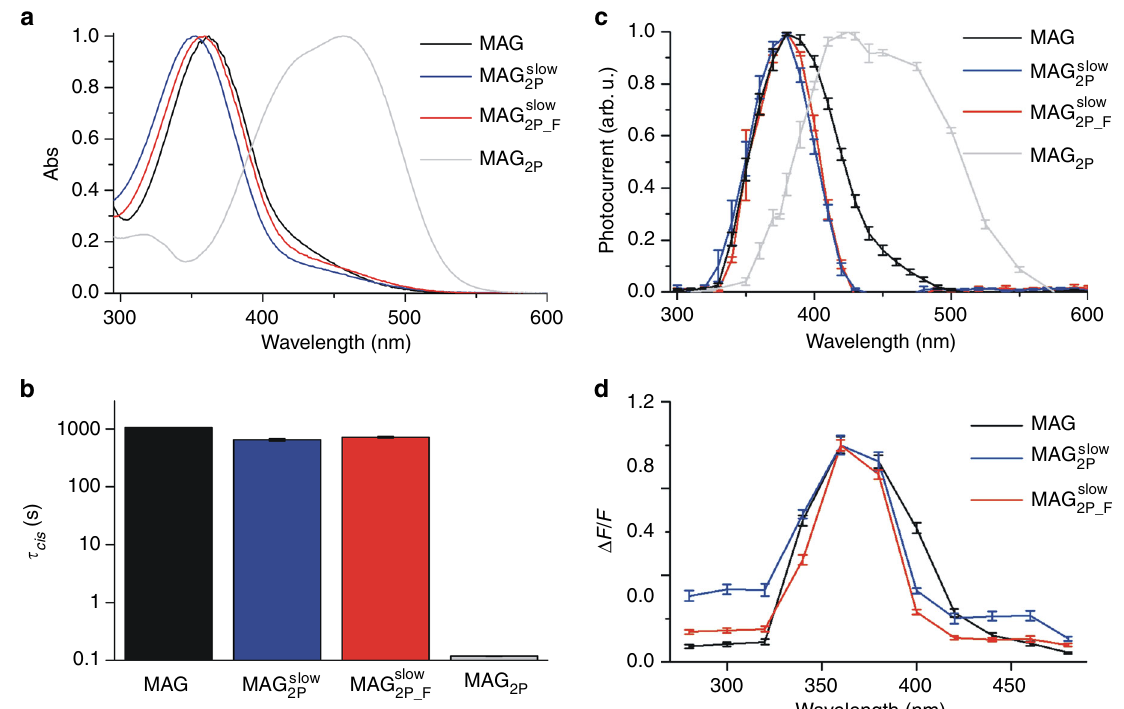
and MAG slow under one-photon (1P) stimulation. a Normalized absorption spectra of Fig. 3 Photochemical and physiological characterization of MAG slow 2P 2P (cid:1) F trans - MAG , trans- MAG slow , trans- MAG slow , and trans- MAG 2P in 99% phosphate-buffered solution (PBS):1% dimethylsulfoxide (DMSO). b Thermal 2P 2P (cid:1) F lifetimes of cis- MAG , cis- MAG slow , cis- MAG slow , and cis- MAG 2P at room temperature in 99% PBS:1% DMSO. Errors from the monoexponentials fi ts to 2P 2P (cid:1) F obtain τ cis are shown. c Normalized 1P action spectra recorded using whole-cell patch-clamp in human embryonic kidney 293 (HEK293) cells expressing GluK2-L439C after conjugation to MAG , MAG slow , MAG slow , and MAG 2P ( n = 5, 7, 3, and 8 biologically independent cells, respectively). Errors are 2P 2P (cid:1) F standard error of the mean (SEM). d Normalized 1P action spectra recorded using calcium imaging in HEK293 cells co-expressing GluK2-L439C and GCaMP6s after conjugation to MAG , MAG slow , and MAG slow ( n = 33, 20, and 25 biologically independent cells, respectively). Errors are SEM. In c and 2P 2P (cid:1) F d wavelength-dependent photoresponses were normalized to the maximum signal along the spectral range measured for each cell before averaging over different cells. Source data for c and d are provided as a source Data fi